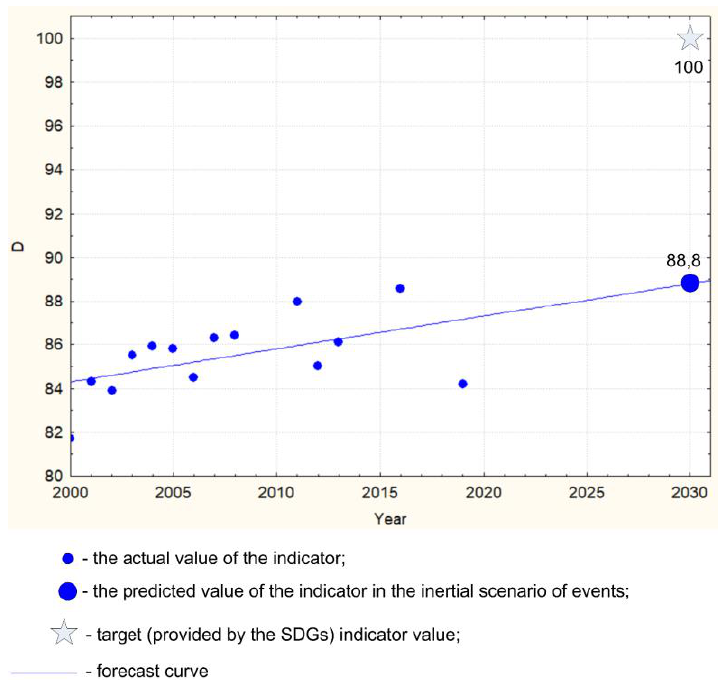
Figure 10: Dynamics of changes in the share of the population with convenient access to public